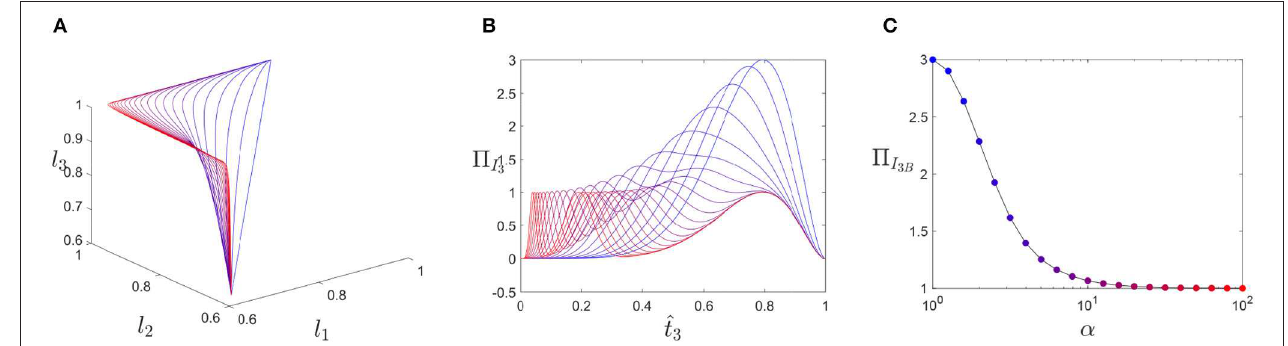
FIGURE 8 | Transition paths for the three-element system in Figure 3B . (A) The path for various α , (B) the energy of system for each path considered, and (C) the maximum energy observed for each path. Line colors in (A,B) transition from blue to red as α increases and correspond to the marker colors in (C) .